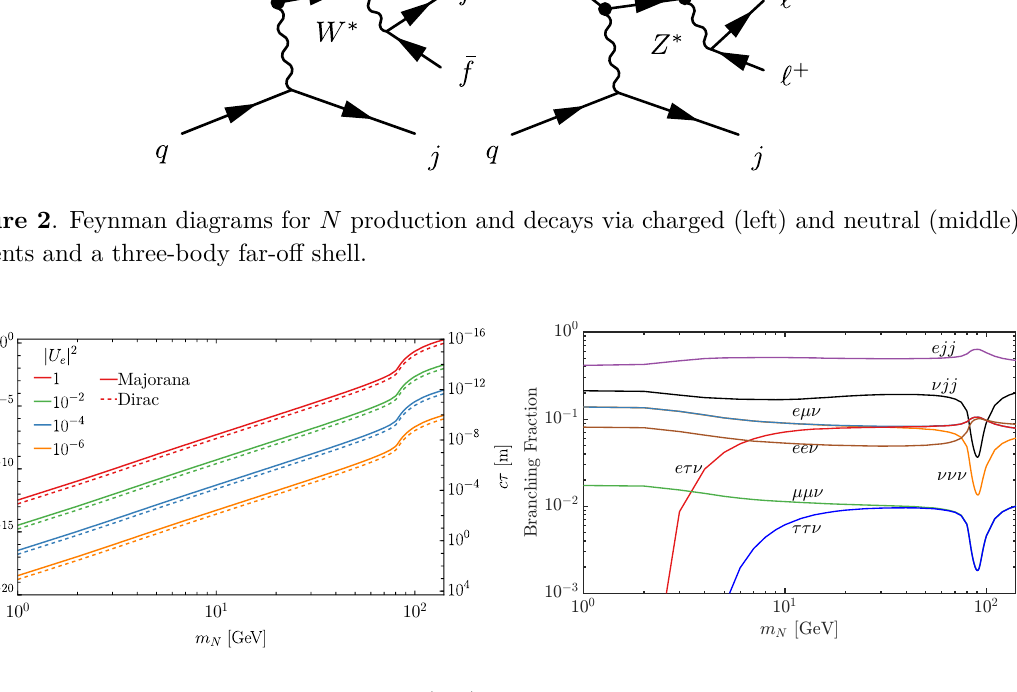
Figure 3 . The HNL total decay width (left) and the branching fractions to final states as labeled